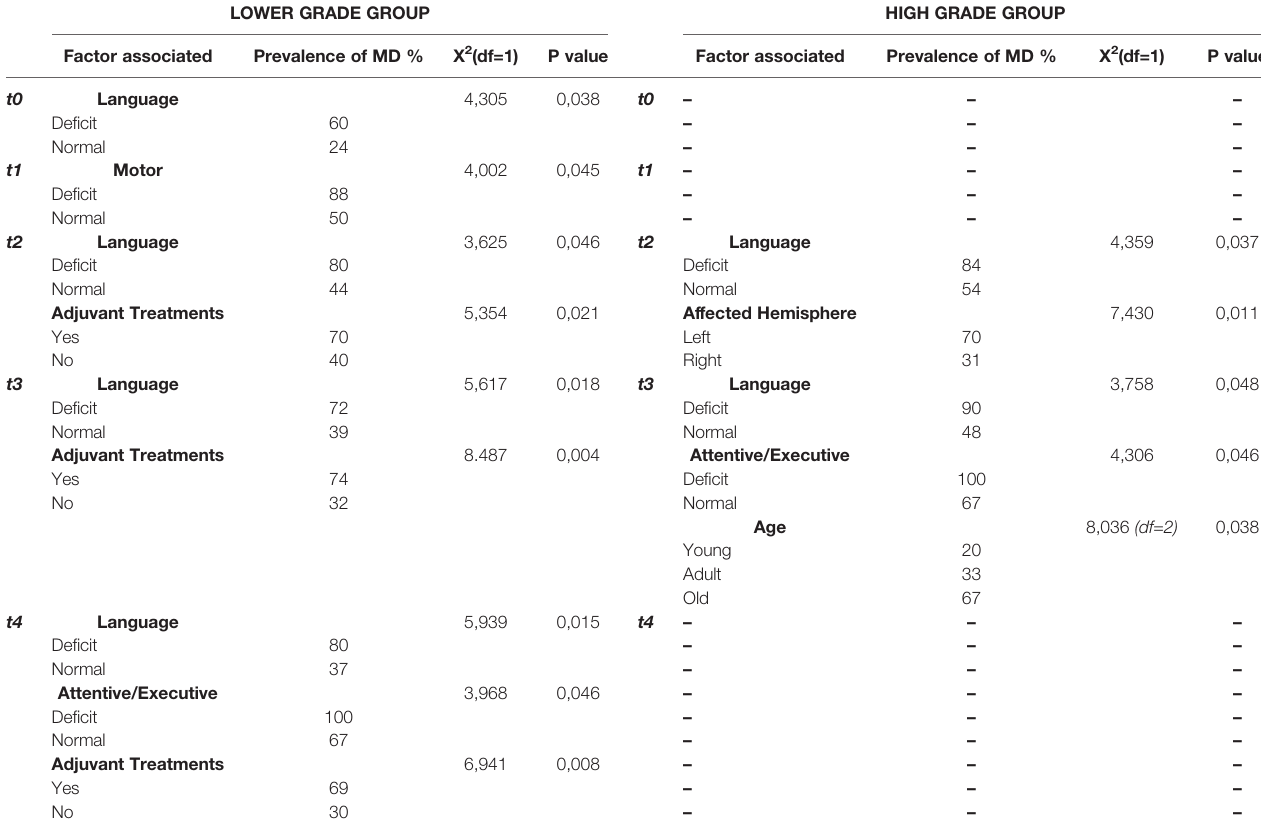
TABLE 3 | Factors associated with mood disorders in lower (LGGs) and High Grade Glioma (HGG). LOWER GRADE